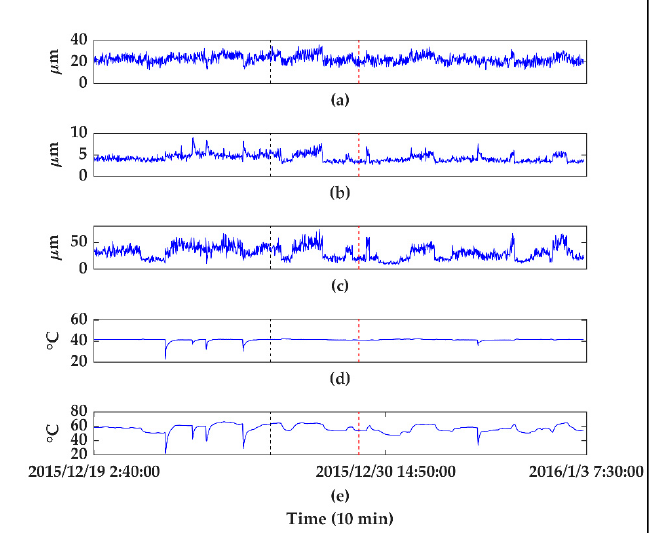
Figure 8. The changing curve of correlation monitoring parameters of hydropower units in case 1: ( a ) vibration of oil receiver in the Y direction, ( b ) vibration of combined bearing in the Y direction, ( c ) vibration of water guide bearing in the Y direction, ( d ) temperature of forwarding thrust bear- ing bush, ( e ) temperature of the stator core.